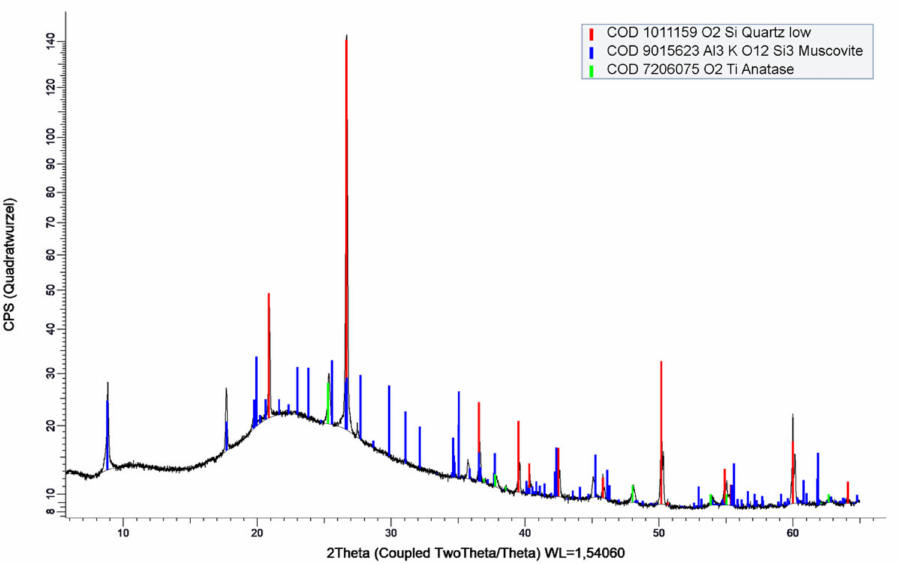
Figure 1. Powder X-ray diffractogram and qualitative analysis of metakaolin (MK1). The second metakaolin MK2 is less pure compared to MK1 and contains impurities mainly of quartz. The qualitative X-ray diffraction diagram is shown in Figure 2, resulting in 46 wt.% amorphous material (~metakaolin), 40 wt.% quartz, 10 wt.% muscovite, and 2 wt.% calcite. Moreover, MK2 has a specific density of 2.5 g/cm 3 and a specific surface of 160,000 cm 2 /g